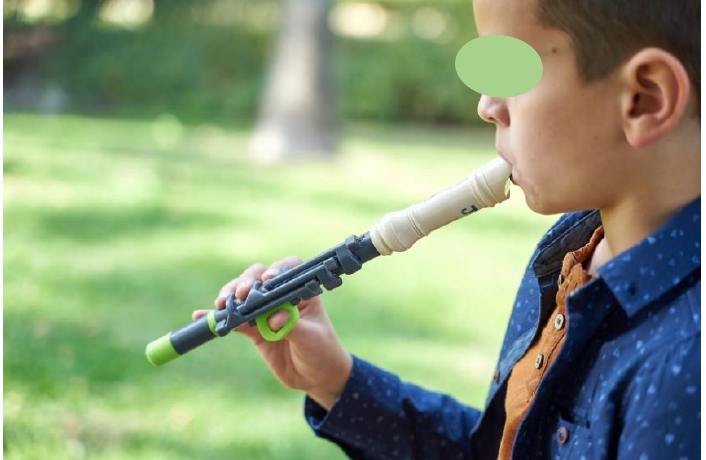
Figure 8. First rehearsals of Jonay (potential user) with Flow.